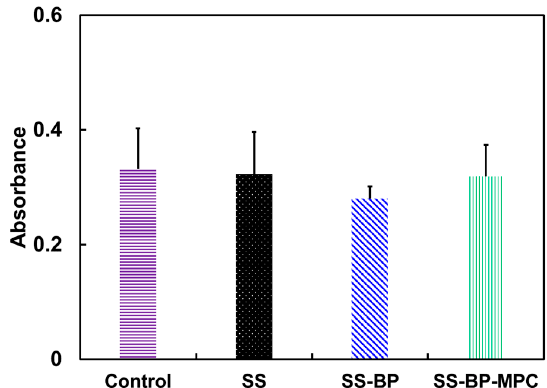
Figure 8. Cytotoxicity of the MC3T3-E1 cell line treated with control, pristine SS, SS-BP, and SS-BP-MPC composites using the dimethylthiazol diphenyltetrazolium bromide (MTT) assay (n = 3). The cells in regular growth medium, without contacting material samples, served as control groups. The statistical analysis indicates the means are not significantly di ff erent at α =